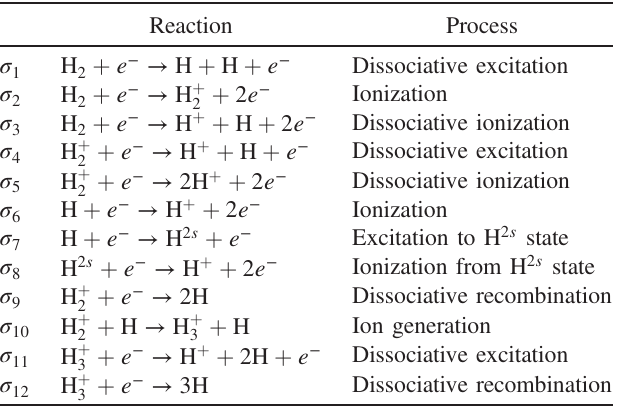
TABLE I. List of the cross sections taken into account for proton fraction estimation